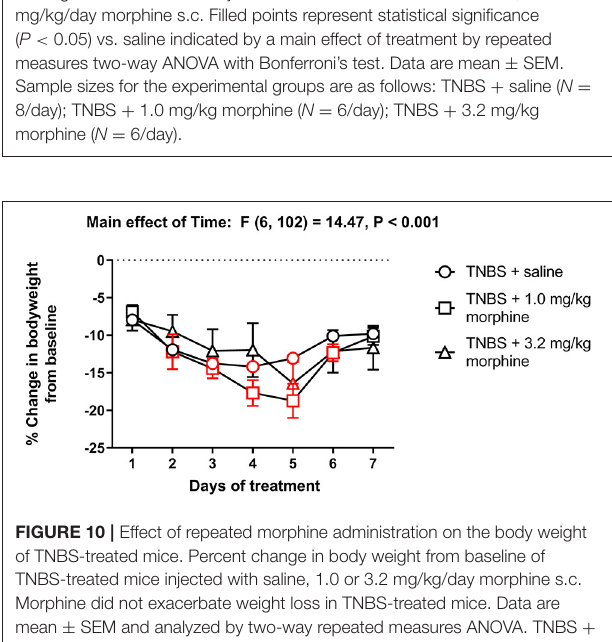
mice injected with saline, 1.0 or 3.2 mg/kg/day